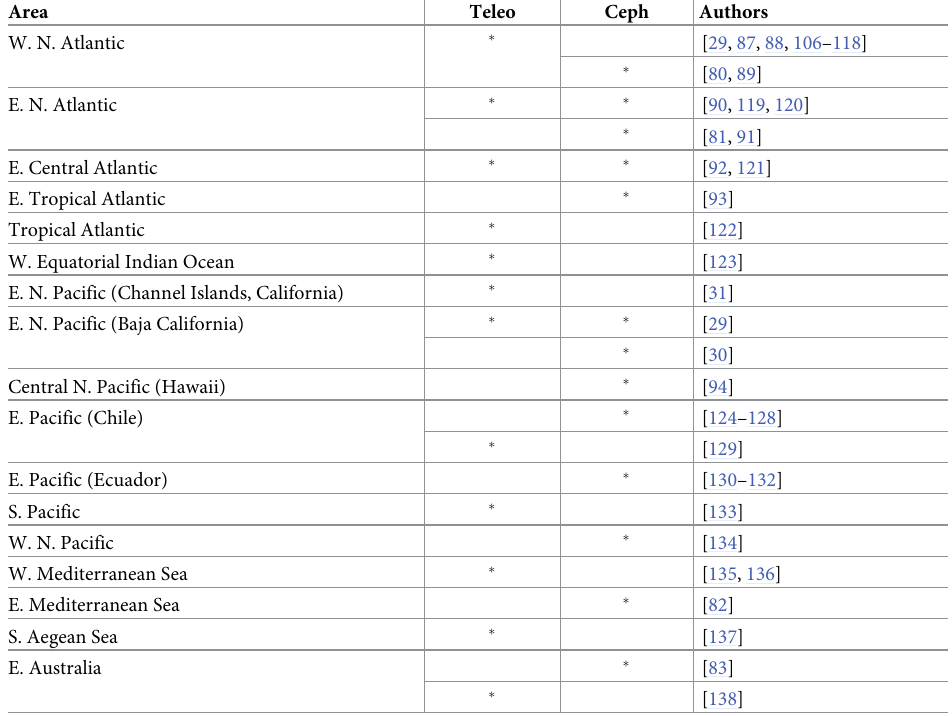
Table 6. Proportion of teleosts and cephalopods, by area, in diet of swordfish based on published studies. ‘ � ’ = highest proportion; W = Western, N = North, E = Eastern, S = Southern, Teleo = teleosts, Ceph =